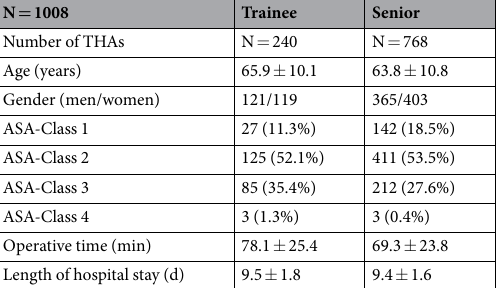
Table 1. Anthropometric characteristics of the study group * . * For categorical data values are given as relative and absolute frequencies, for quantitative data values are given as mean (standard deviation), THA = total hip arthroplasty, ASA = American Society of